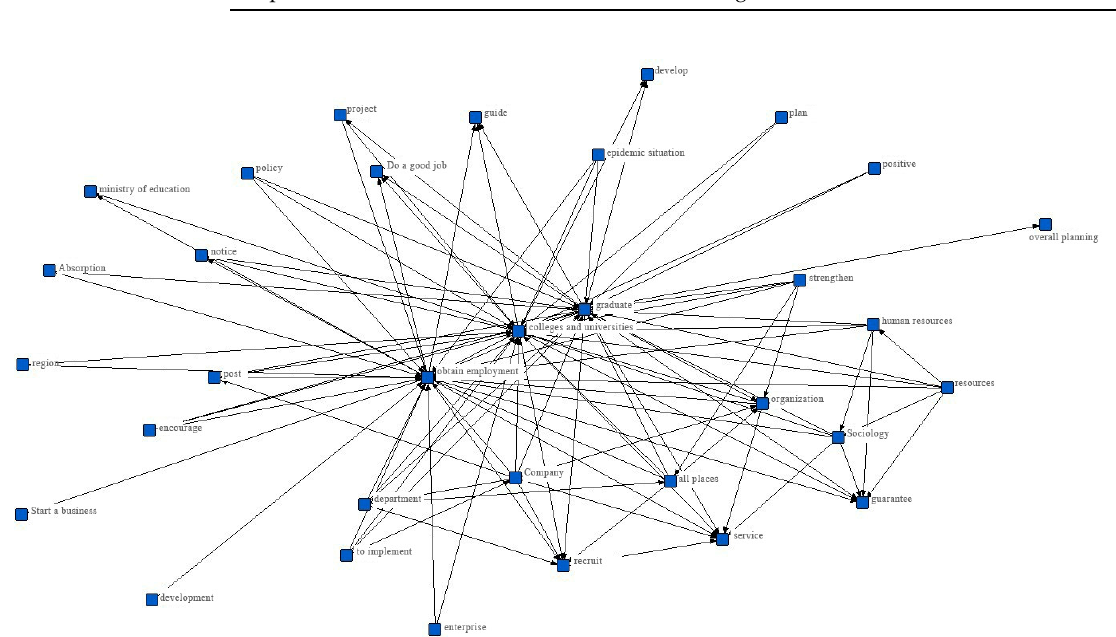
Figure 2. Co-citation networks of keyword in employment promotion policy documents for college